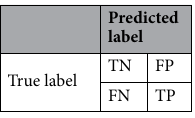
Table 1. Confusion matrix table.